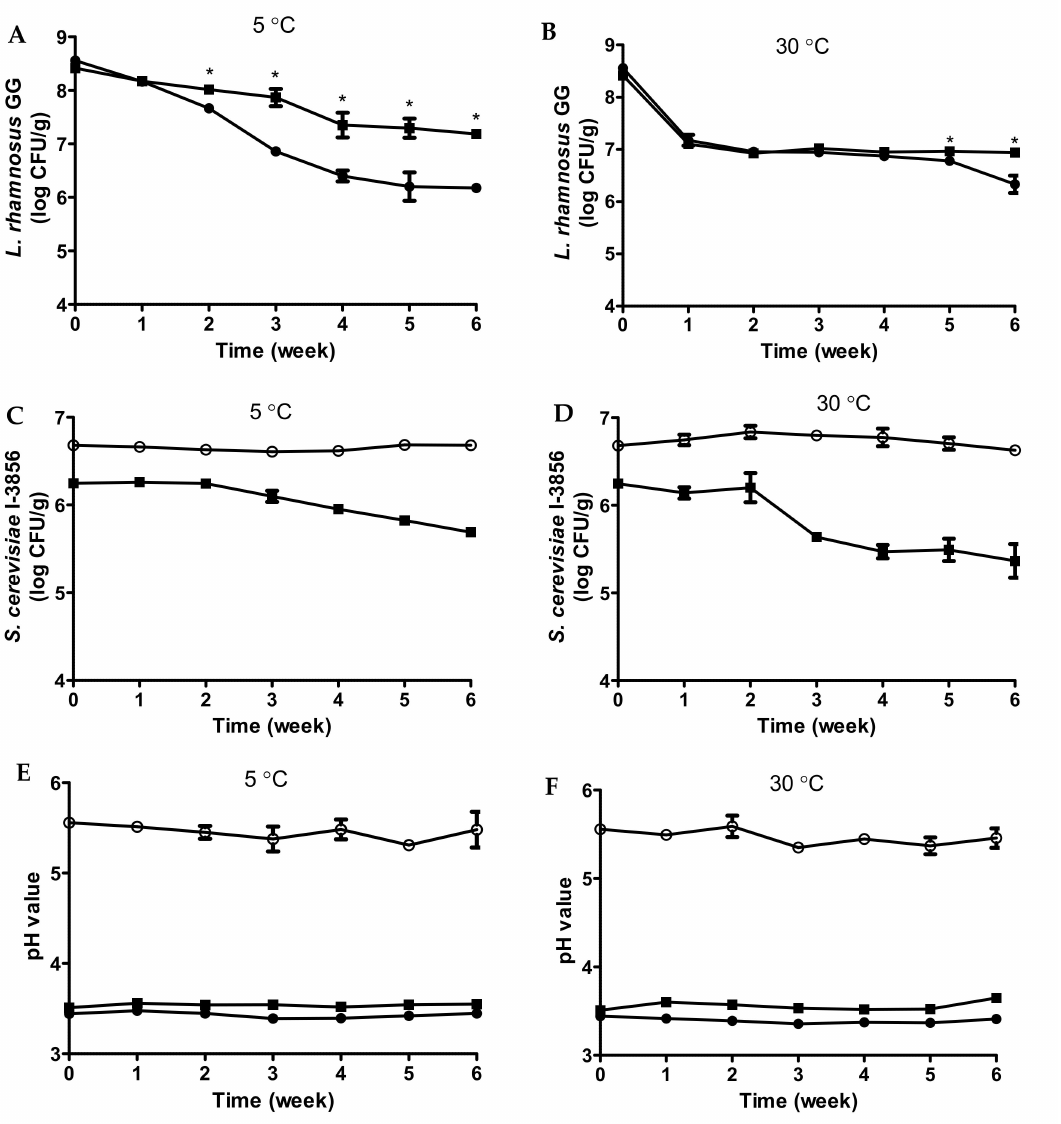
Figure 5. Changes in viable L. rhamnosus GG cell counts during storage at 5 ( A ) and 30 ◦ C ( B ). Changes in viable S. cerevisiae CNCM I-3856 cell counts during storage at 5 ( C ) and 30 ◦ C ( D ). Changes in pH during storage at 5 ( E ) and 30 ◦ C ( F ) for fermented bread beverages inoculated with L. rhamnosus GG monoculture ( • ), S. cerevisiae CNCM I-3856 ( ), and co-culture ( (cid:4) ) followed by 37 ◦ C incubation for (cid:35) 16 h. * Indicates significant differences ( p < 0.05) at the same time